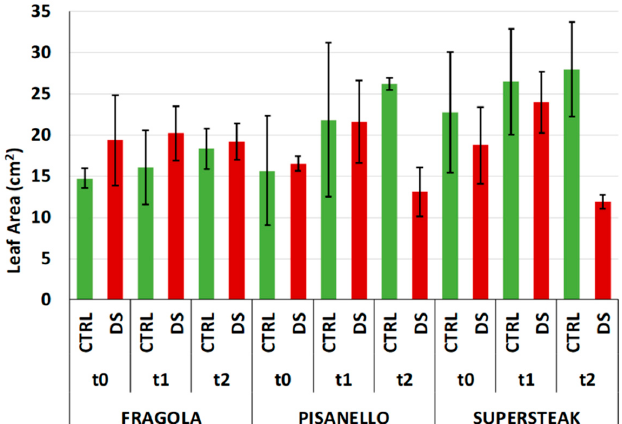
Figure 7. Leaf Area in two local varieties (‘Fragola’ and ‘Pisanello’) and one commercial cultivar ‘Supersteak’ of tomato ( Solanum lycopersicum L.) subjected to drought stress (no water for 16 days) relative to the controls (regularly well-watered plants). Two-way factorial ANOVA followed by Tukey post-hoc test was used to determine the statistical significance of di ff erences. Points with the same lower-case letters do not differ significantly ( p > 0.05). The p-values for ‘Pisanello’ and ‘Supersteak’ are near to significance, respectively p = 0.07 and p = 0.08. t 0 = before the start of treatment, t 1 = half duration of the stress, t 2 = the end of the stress. Plants 2019 , 8 , x FOR PEER REVIEW